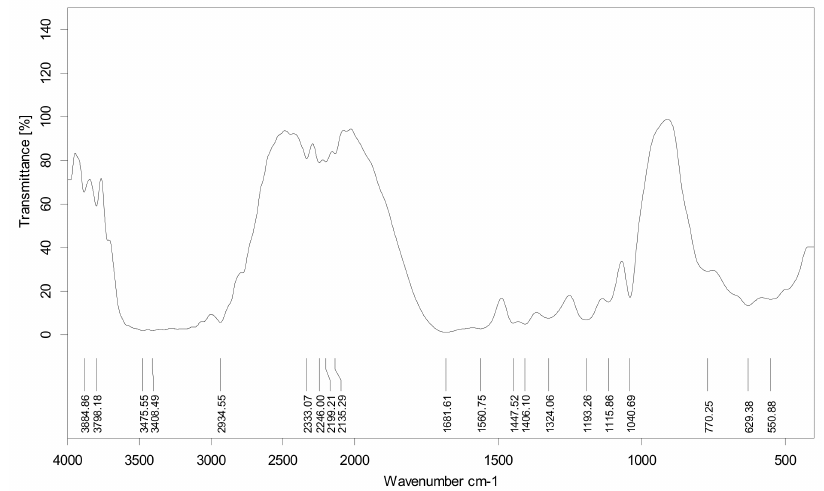
Figure 2. Infrared spectrum of the new